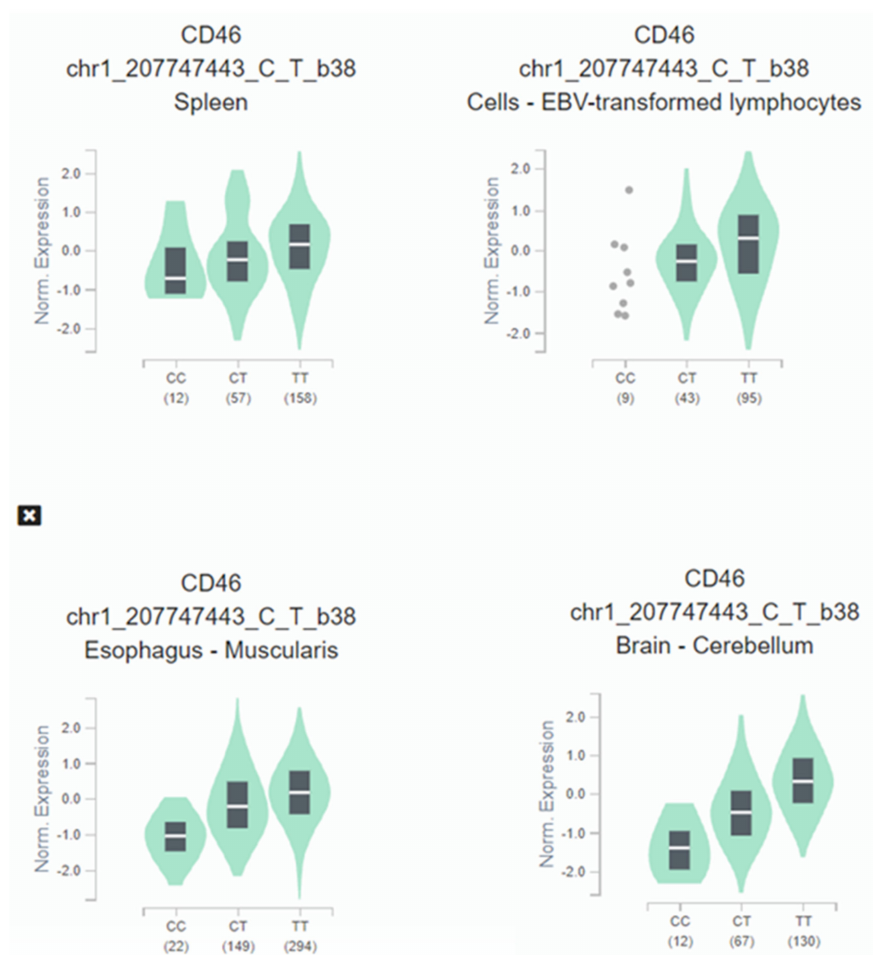
Figure 3. Illustrative violin plot where CD46 normalized expression is plotted according to the rs2796265 genotypes determined in cultured fibroblasts, spleen, brain, and immortalized B-lymphocytes according to GTEX portal. Protective genotype CC show significative lower levels of expression in several representative tissues: Esophagus ( p = 5.9 × 10 − 53 ), brain ( p = 1.7 × 10 − 36 ), spleen ( p = 3.1 × 10 − 7 ), immortalized B-lymphocytes ( p = 1.0 × 10 − 6 ). The values between parentheses represent the number of samples included in each